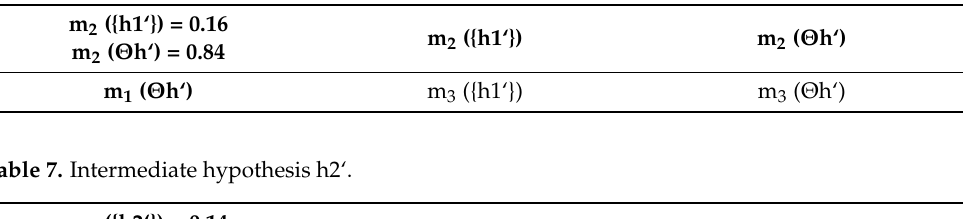
Table 6. Intermediate hypothesis h1‘.